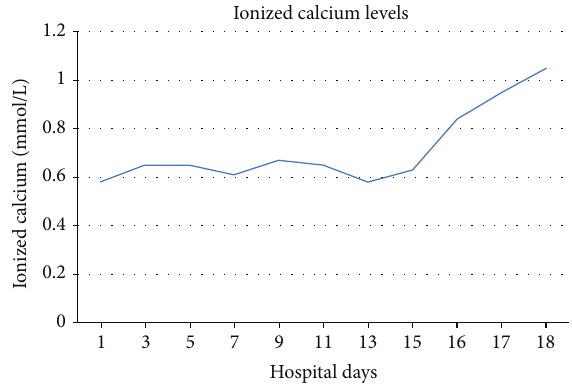
Figure 2: Ionized calcium levels during the hospital stay. Hemodial- ysis was initiated on day 16 due to worsening renal failure and persistent